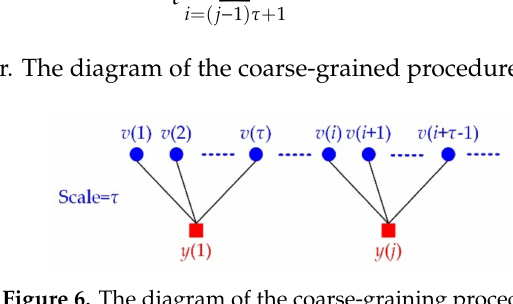
Figure 6. The diagram of the coarse-graining